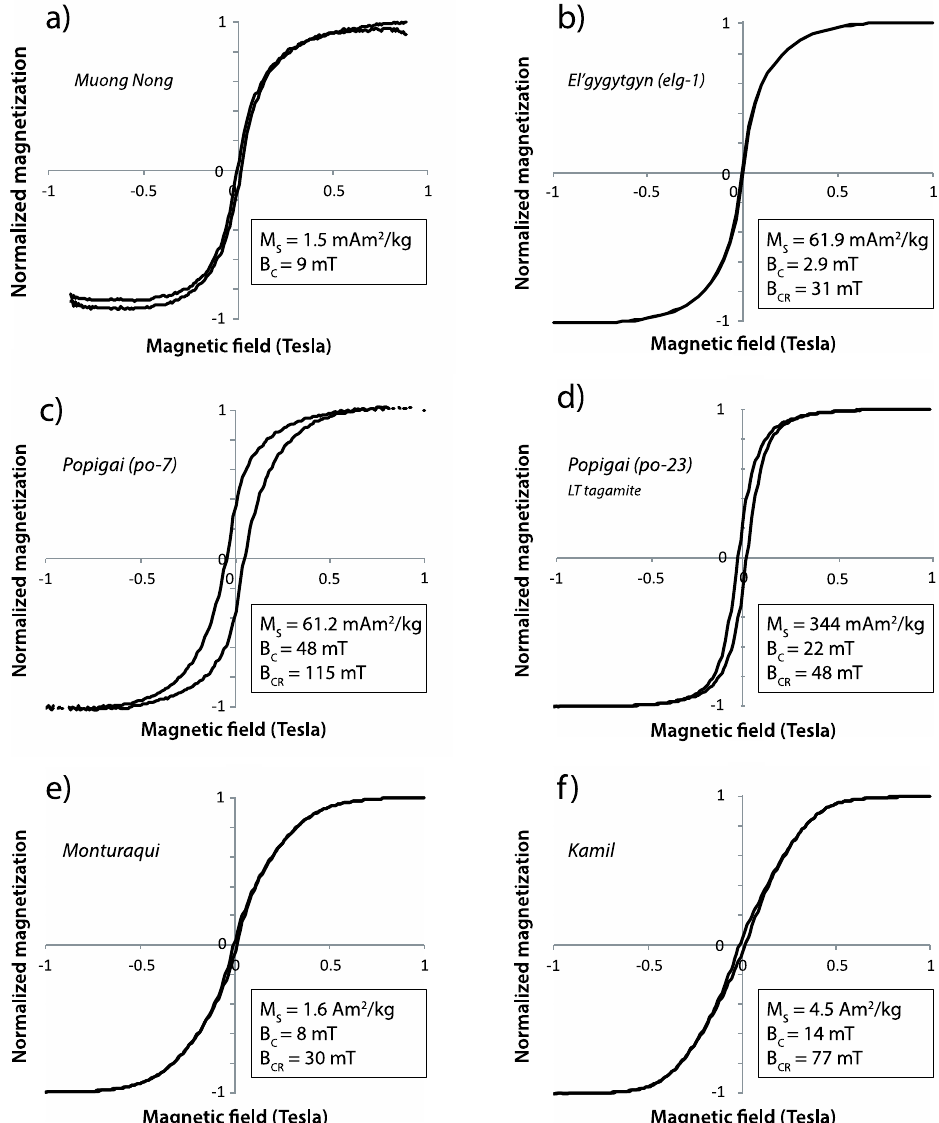
Figure 4. Examples of hysteresis loops, corrected for paramagnetism, obtained on impact glasses: ( a ) a titanomagnetite-rich Muong Nong tektite (note that strong paramagnetism prevented to obtain a well defined closed loop); ( b ) titanomagnetite-dominated El’gygytgyn glass; ( c , d ) pyrrhotite or magnetite-dominated Popigai glasses PO-7 and PO-23, respectively; ( e , f ) metal-bearing Monturaqui and Kamil glasses, respectively. LT tagamite is low-temperature tagamite (see Section 4.2.2).